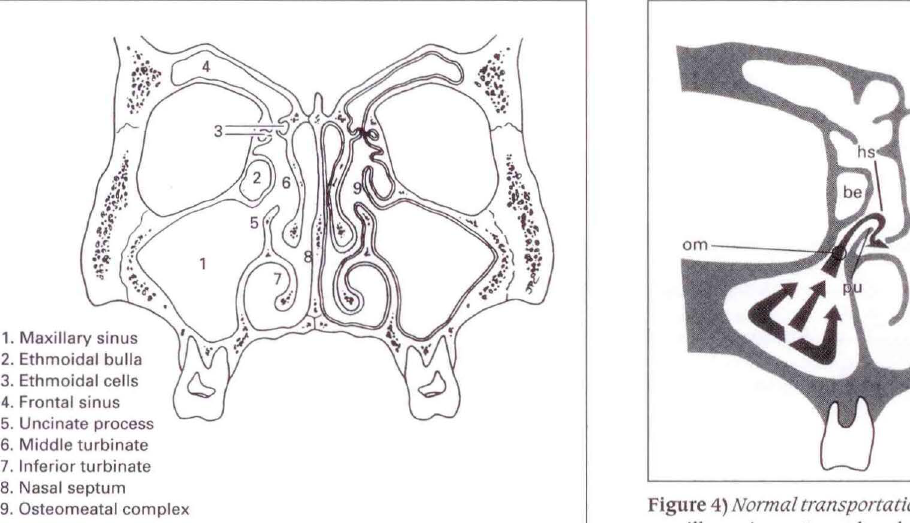
Figure 4) Nonna! transportation pathways qfmucus movingoutqf the maxillary sinus. Reproduced with permission.from reference 30. be Ethmoidal bulla; hs Hiatus semilunaris; om Maxillary ostium; pu Un c inate